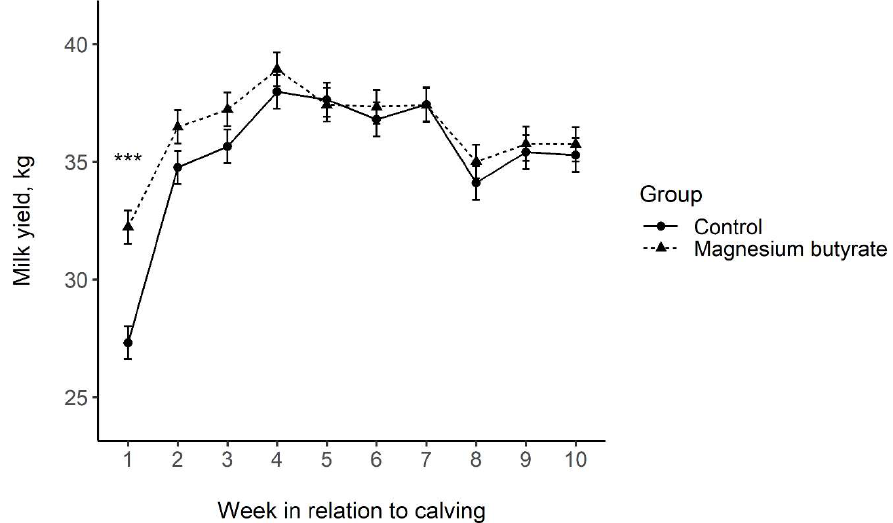
Figure 1. Weekly averages of daily milk yields of Control ( • , n = 112) and Magnesium butyrate ( ▲ , n = 107) groups during the first 70 DIM. Statistical significance is based on pairwise compari- sons after fitting a linear mixed effects model. Results are presented as estimated marginal means ( ± SEM); *** p < 0.001.